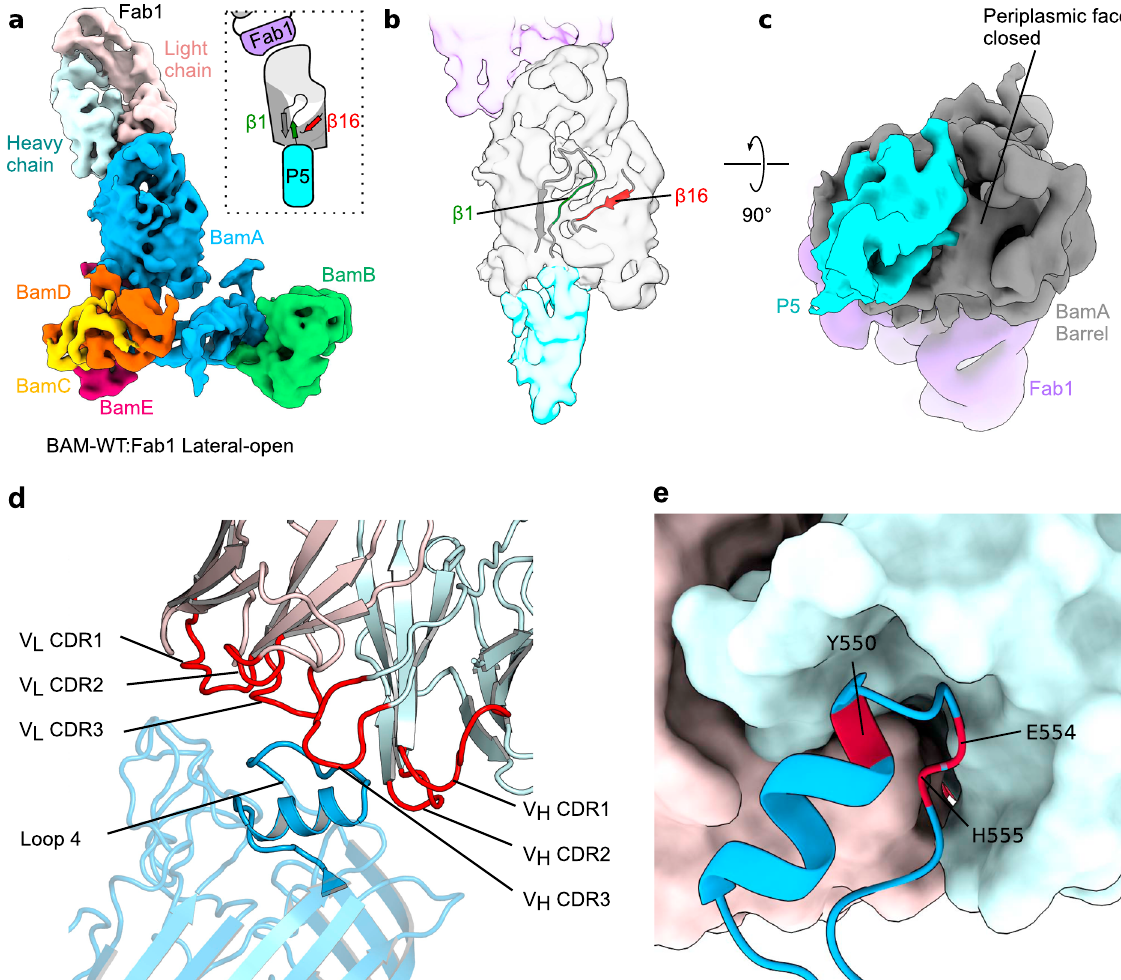
Fig. 3 Fab1-bound BAM is in a lateral-open conformation. a 5.1 Å cryoEM map of the BAM – Fab1 complex in a lateral-open conformation at a contour of 10 σ , coloured by subunit. The lateral gate is fully open and POTRA-5 occludes the BamA barrel ( schematic inset ). b Cartoon representation of the corresponding atomic model at the lateral gate superimposed on the segmented density for the barrel and POTRA-5 of BamA. β 1 is in a conformation that makes limited contact with β 16. c The same density viewed from the periplasmic side, showing that the BamA lumen is blocked by POTRA-5 in this conformation. Panels made using UCSF ChimeraX 76 . Segmenting and colouring performed with corresponding atomic models. Less well-resolved regions and the micelle have been masked. d Close up of the BamA – Fab1 interface region highlighting the Fab1 CDRs ( red ) interacting with eL4 of BamA ( dark blue) . Other regions of BamA are rendered semi-transparent to highlight eL4. Heavy and light chains of Fab1 are coloured cyan and pink , respectively. e The V L and V H domains of Fab1 variable form a complementary binding surface for eL4 of BamA involving residues Y550, E554 and H555 (red). Sidechains for Y550, E554 and H555 are not shown as they are not well-de fi ned in the electron density, but the close location of these residues in the binding pocket is consistent with previous mutagenesis studies 16